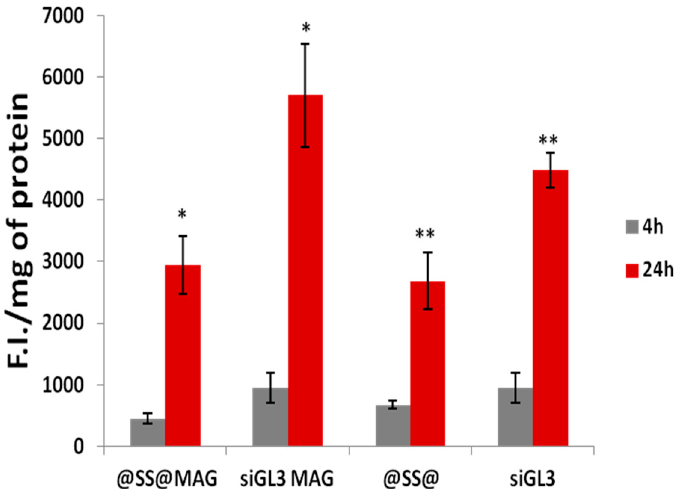
Figure 11. Uptake on MCF-7 cells (4 and 24 h incubation) of ICD@SS@SPIONs/siRNA with (@SS@MAG) and without (@SS@) the application of an external magnetic field. Results were compared with cells treated with free siRNA in the presence (siGL3MAG) or not (siGL3) of the external magnetic field. A statistically significant difference was found between groups headed by the same symbol (*; **) with p ≤ 0.05.